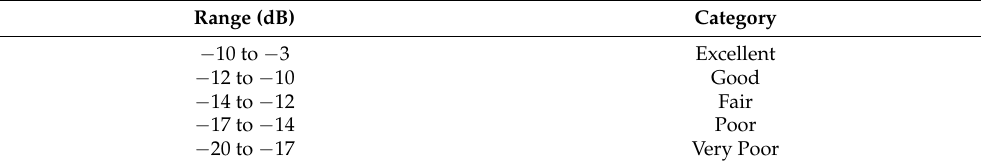
Table 10. Performance indicator standards for RSRQ [42].